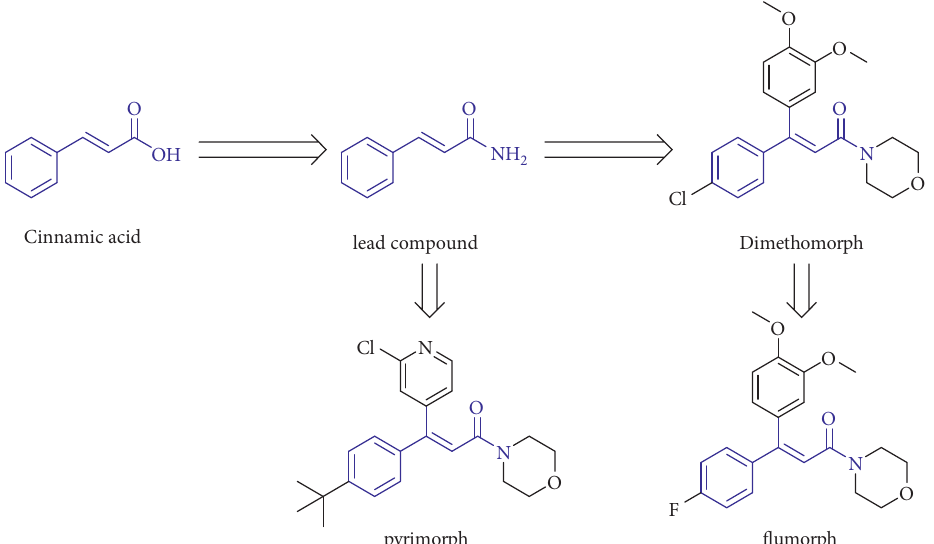
Figure 2: Cinnamic acid amide fungicides successfully developed based on natural product cinnamic acid.